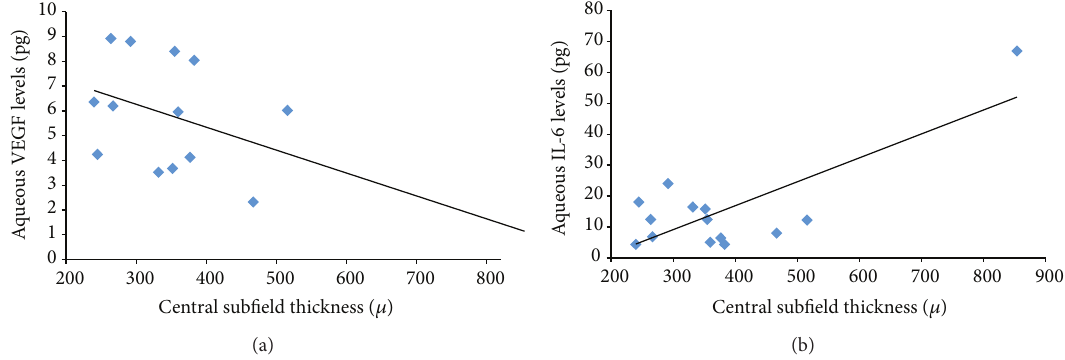
Figure 5: Correlation plot showing correlation between aqueous VEGF (a) and aqueous IL-6 levels (b) with central subfield thickness on Spectralis OCT in patients in group